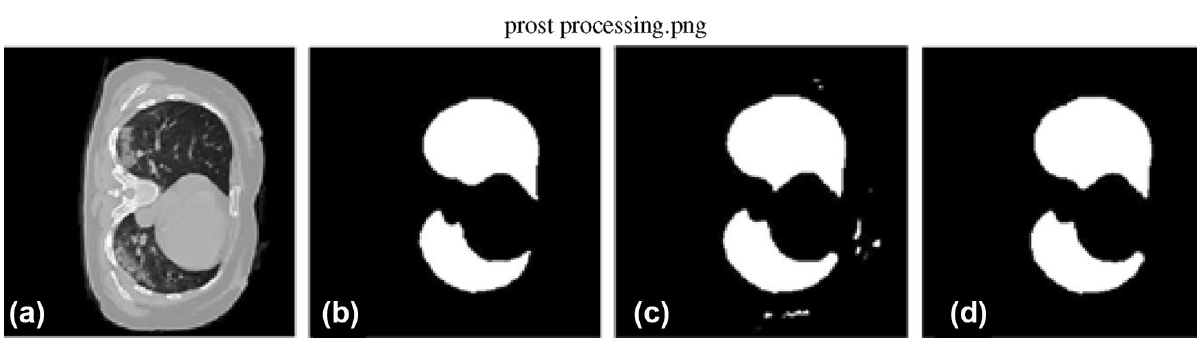
Figure 5. Post processig after lung parenchyma